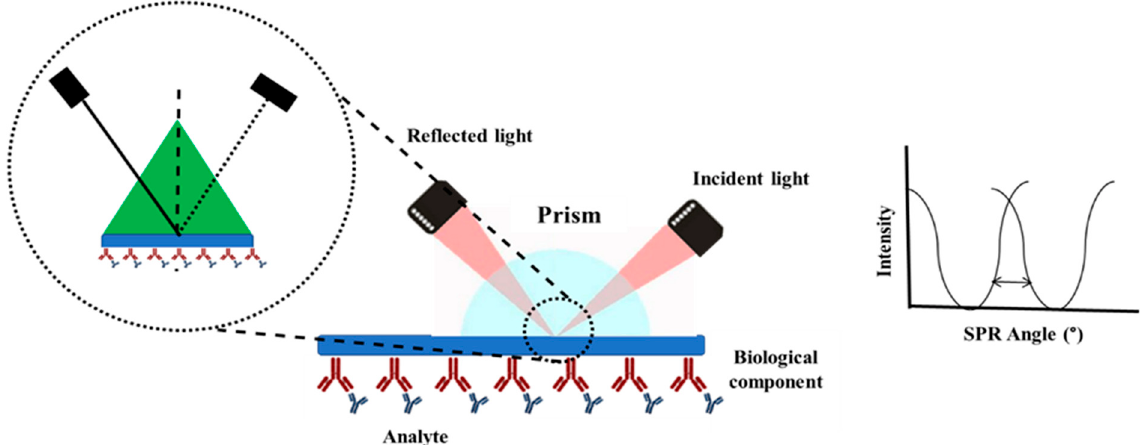
Figure 3. Schematic depiction of the SPR. A monochromatic laser is reflected on the surface. The plasmons generated by the surface are excited at a specific angle. The reflected light is continuously measured. This angle is affected by the analyte linked to the biological element on the surface. (Created with Biorender.com (accessed on 13 February 2023)).